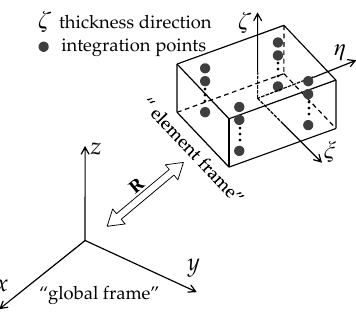
Figure 2. Element frame and global frame for the proposed SHB elements.